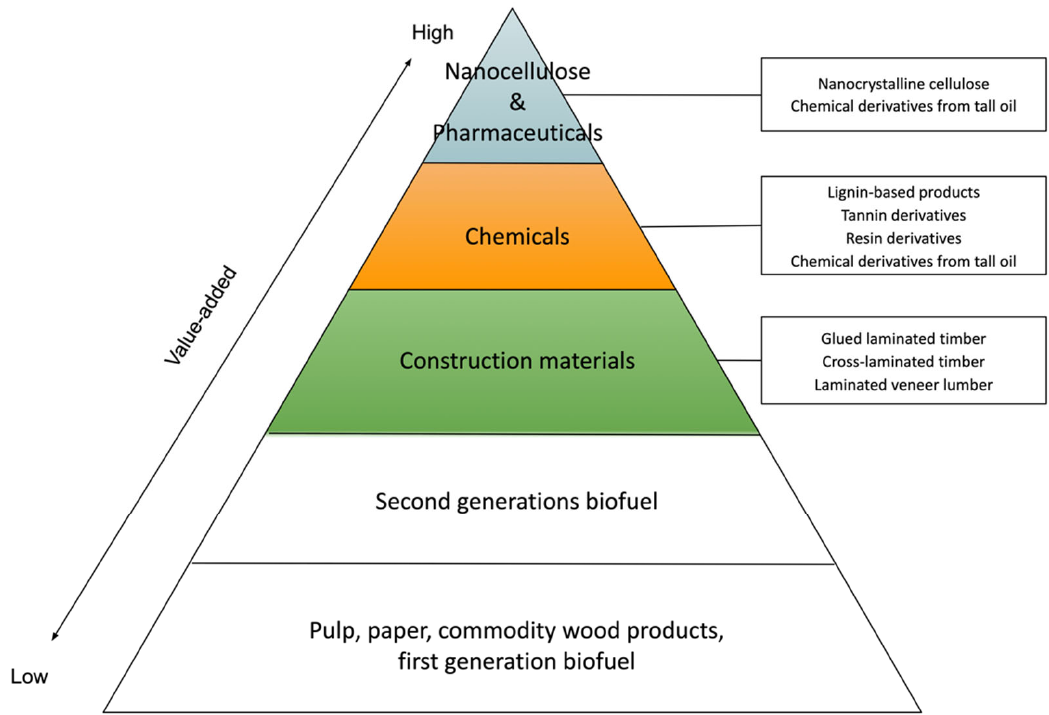
Figure 1. Forest biomass value pyramid (adapted from [50]), and innovative forest products manu- factured in Brazil (in boxes).